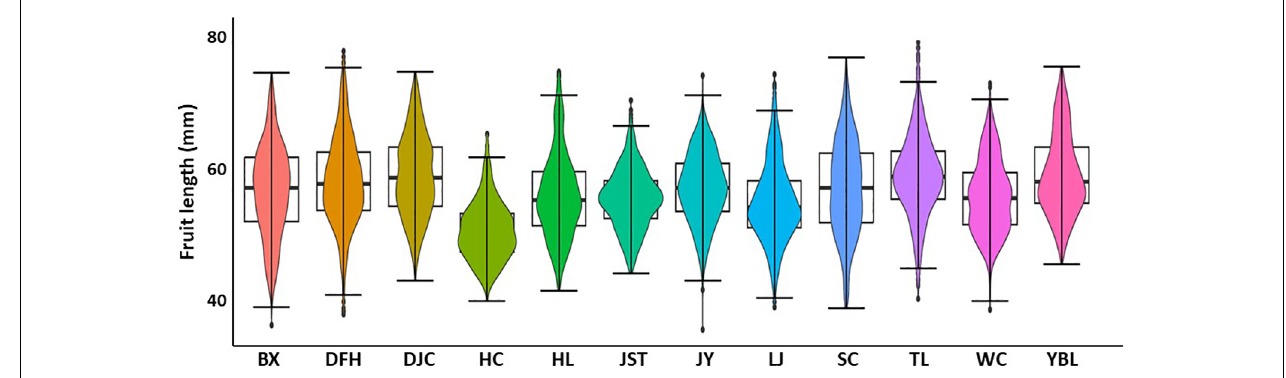
FIGURE 3 | Boxplot showing the distribution of fruit length in 12 J. mandshurica populations. BX, Binxian, HLJ; DFH, Raohe, HLJ; DJC, Ning’an, HLJ; HC, Hunchun, JL; HL, Hulin, HLJ; JST, Yichun, HLJ; JY, Jiayin, HLJ; LJ, Linjiang, JL; SC, Baishan, JL; TL, Tieli, HLJ; WC, Wuchang, HLJ;YBL, Yabuli, HLJ. HLJ,